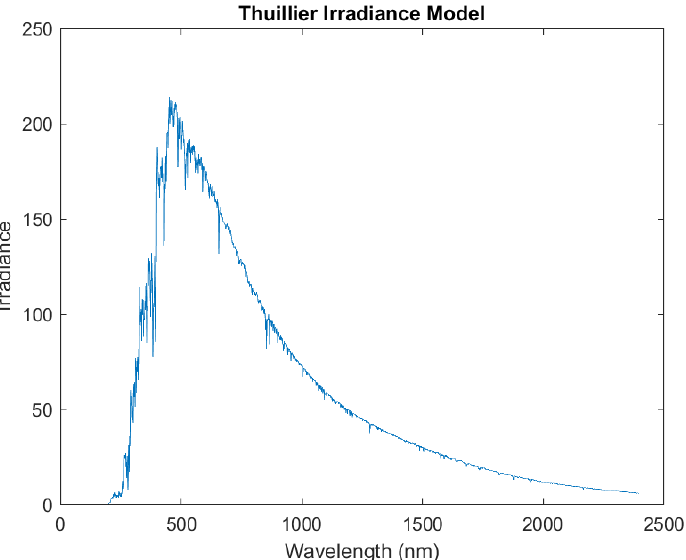
Figure 14. Thullier irradiance model. This irradiance was applied to the reflectance curves in the SDSU-compiled spectral library to determine the radiance of each sample. Table 9. Radiance SBAF-corrected cross-calibration gain estimates. These values are further from unity than the reflectance values, which was the main focus of Phase 1.